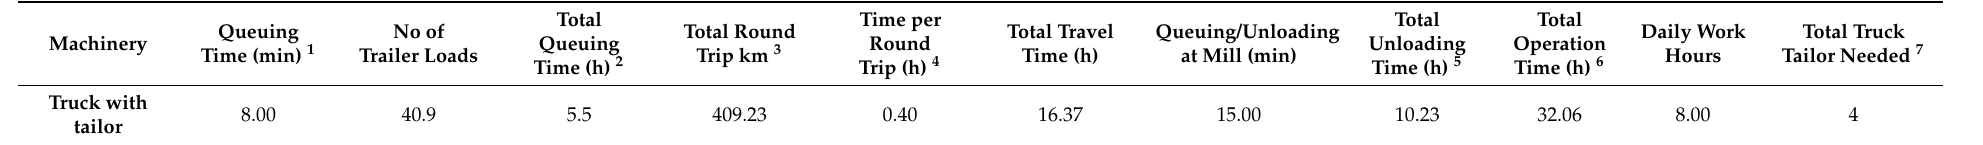
Table 4. Estimated number truck trailers for transportation of harvested